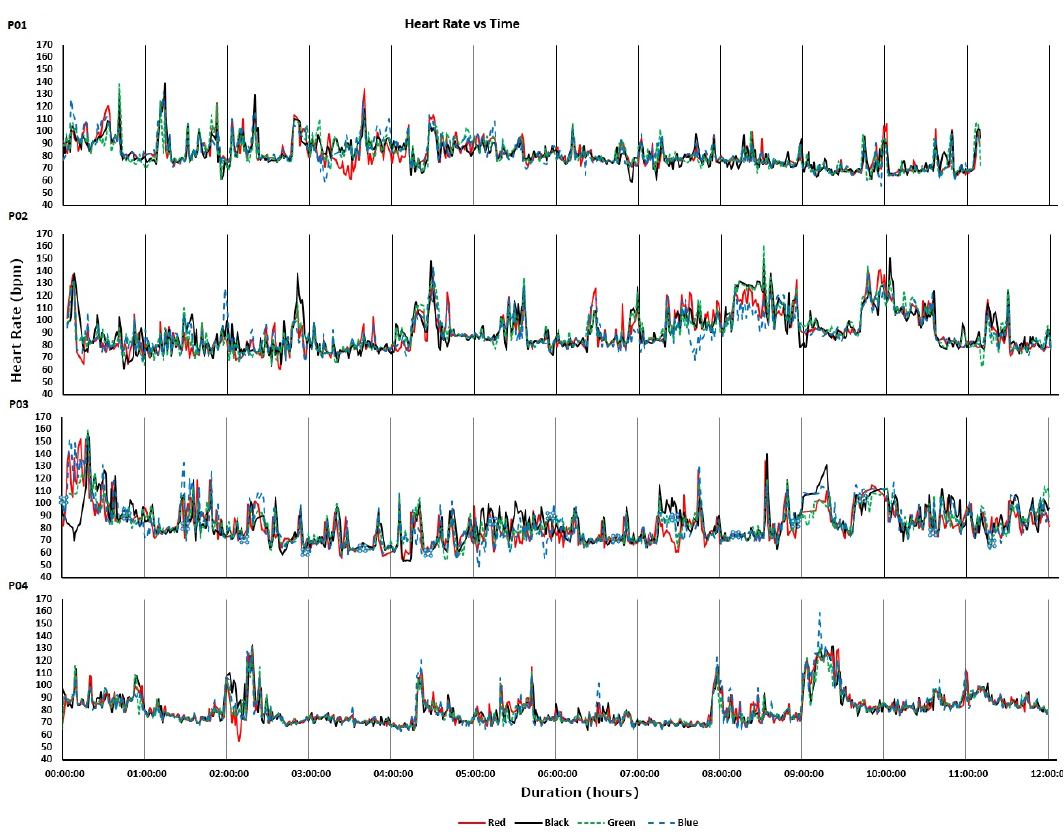
Figure 5. Heart rate recordings acquired during 12 h of everyday